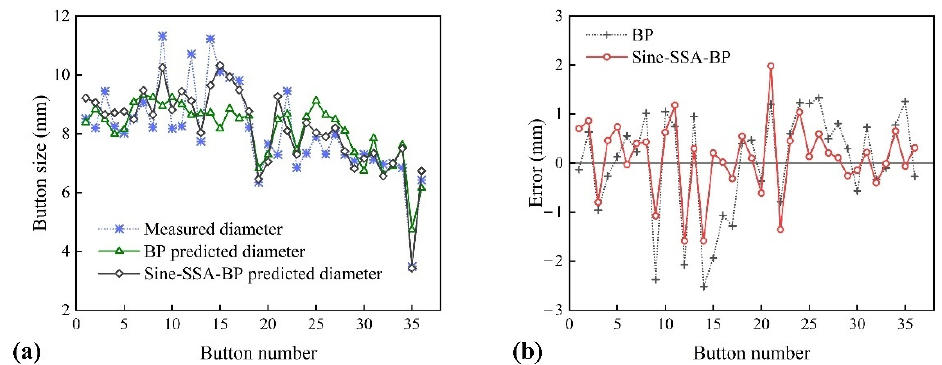
Figure 9. Prediction and error comparison between BP and Sine-SSA-BP model: ( a ) prediction comparison of button size; ( b ) error comparison of BP and Sine-SSA-BP.